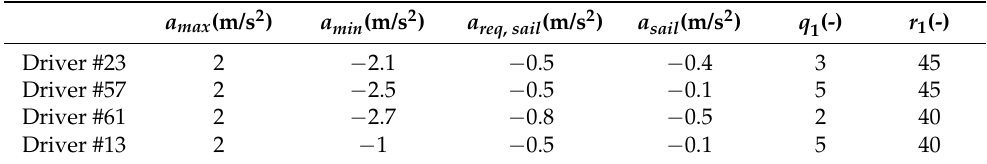
Figure 11. Computer simulation results to compare the Gipps model (compared) and the proposed driver model (proposed): ( a ) the case of SPMD driver #61; ( b ) the case of SPMD driver #13 (cut- in/out situation). Table 4. Driver model parameters for simulation